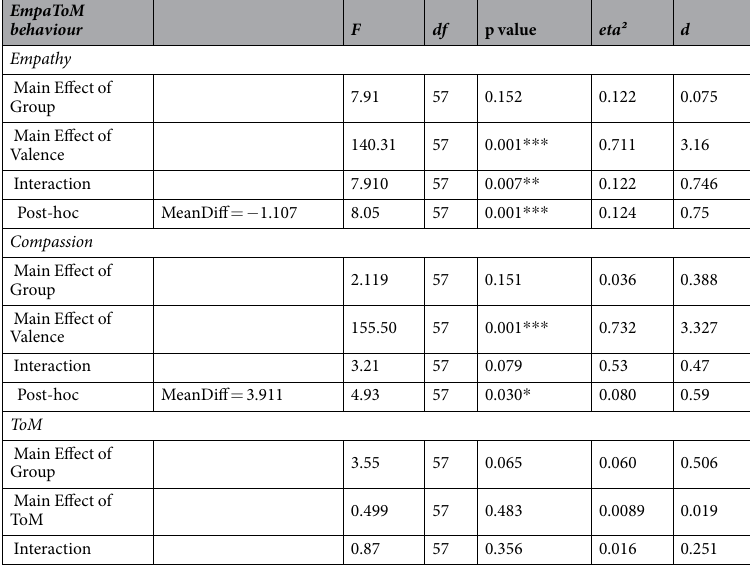
Table 2. EmpaToM measures analysed by means of separate repeated-measures analyses of variance. Note: * Indicates statistical significant p-value: * p ≤ 0.05, ** p ≤ 0.01, *** p ≤ 0.001.